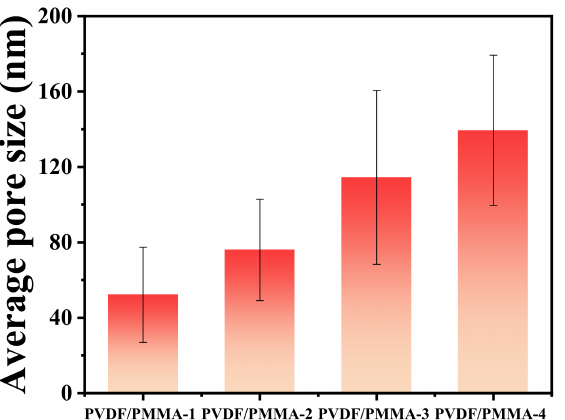
Figure 9. The average pore size of PVDF/PMMA blends with different molecular weights after extraction by CHCl 3